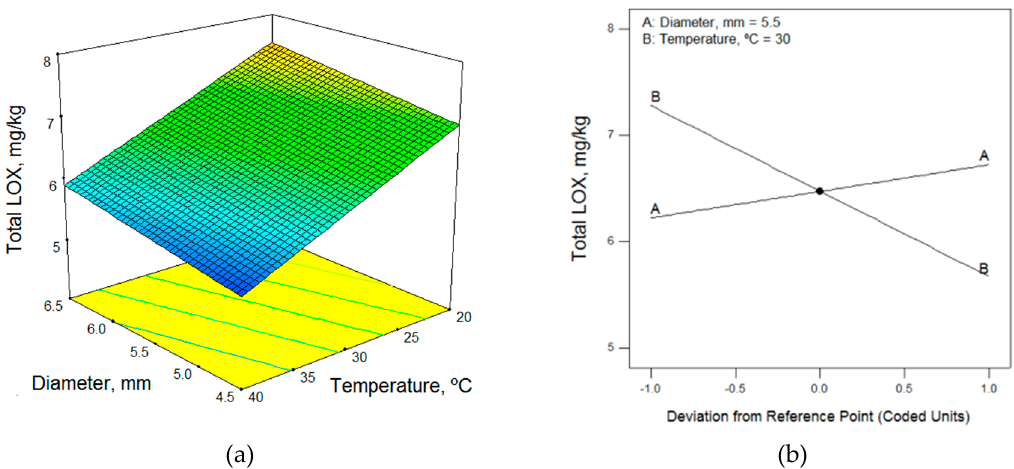
Figure 2. (a ) Response surface and ( b ) perturbation graphic of the effects of temperature and time on the total LOX volatile content for the Koroneiki cultivar (rainfed, MI = 2.05); time does not have an influence.